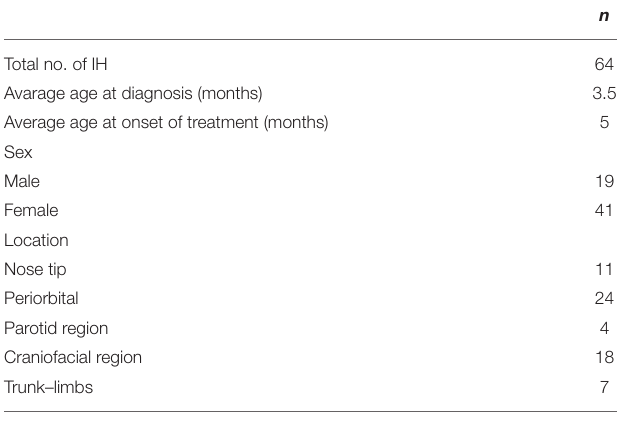
TABLE 1 | Demographic and clinical data of all infantile hemangiomas (IHs). TABLE 2 | Distribution of patients and type of IHs during different controls over